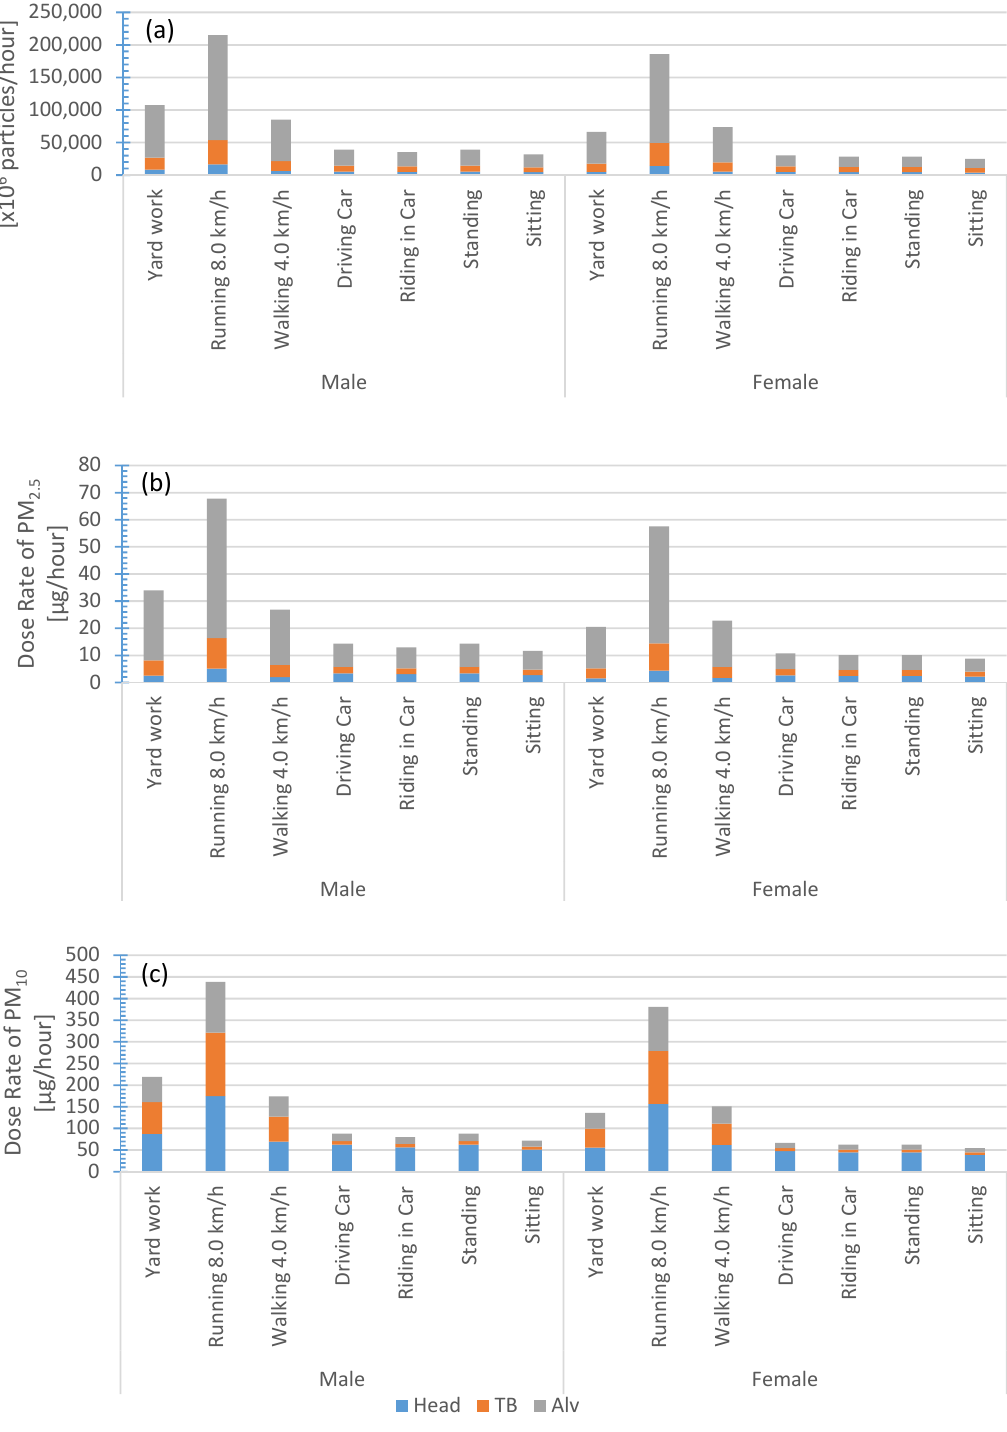
Figure 7. Amman city center; regional inhaled deposited dose rates calculated for di ff erent activities and genders: ( a ) submicron particle number concentration and ( b , c ) particulate matter PM 2.5 and PM 10 . The color legend is: (blue) head airways, (red) tracheobronchial, and (green) alveolar. According to Equation (1), the regional dose rate is dependent on several main factors: (1) geographical factor, (2) physical characteristics of the particle number size distribution, (3) activity type (exercise versus relax / rest), (4) gender, and (5) concentration metric (number versus mass) and